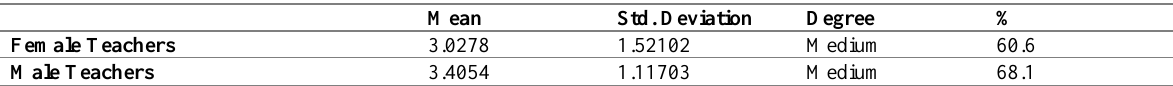
Table 4: Productivity in Teaching